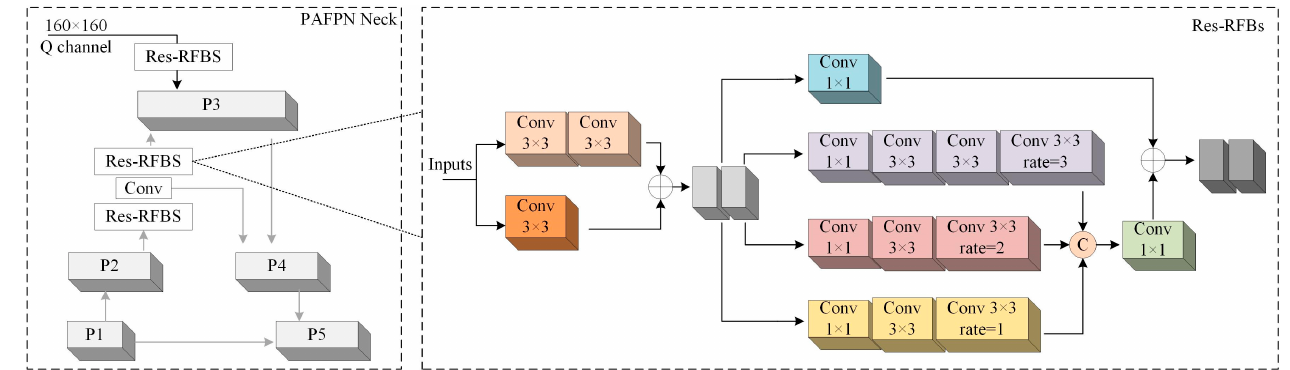
Figure 4. Improved feature detection structure.